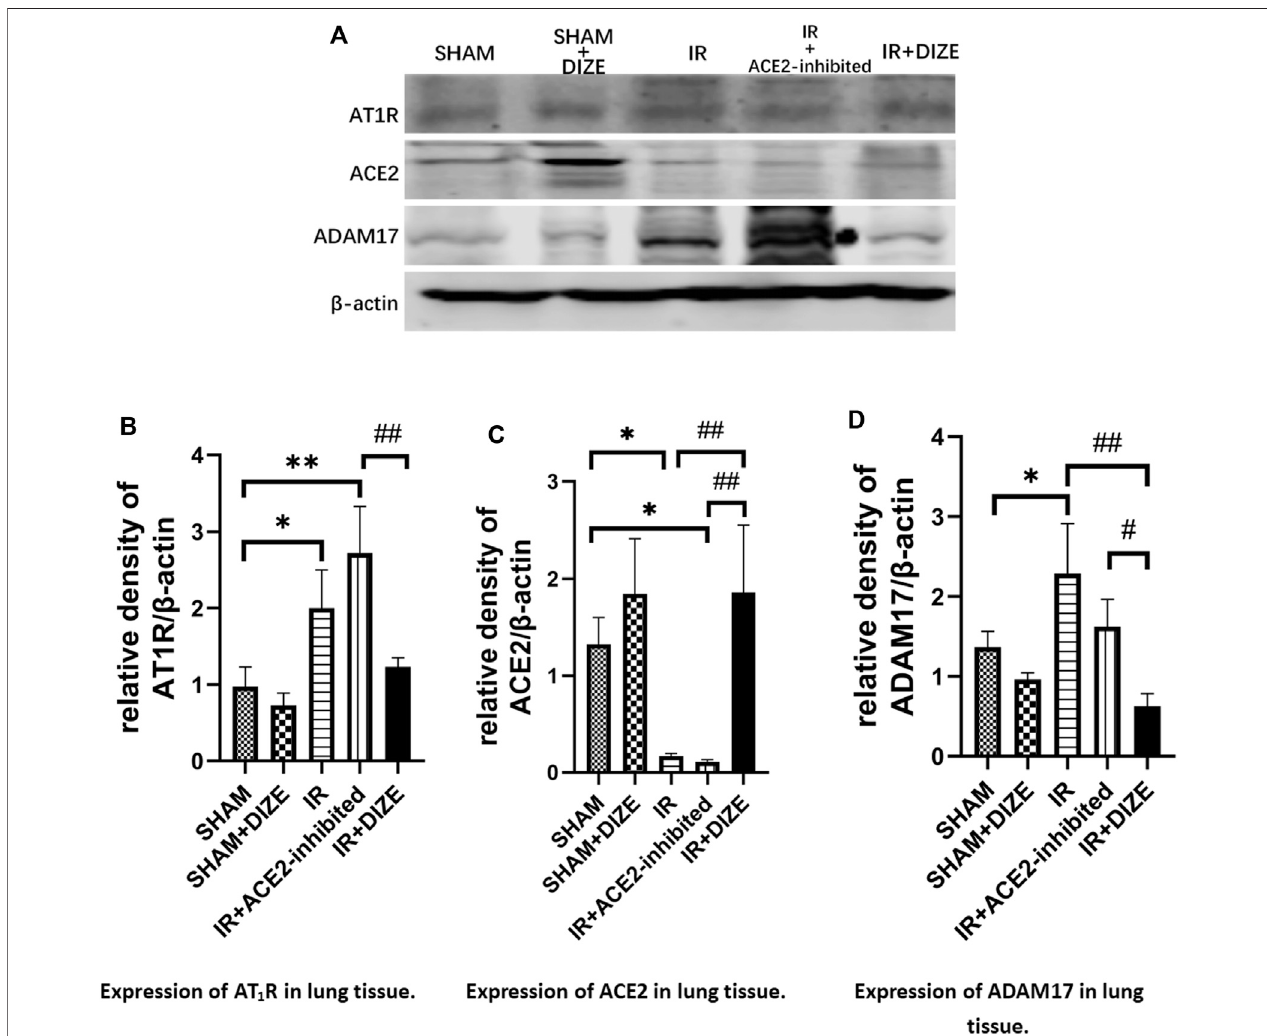
FIGURE6| DIZEreducedADAM17expressionafterIRinjuryandprotectedlocalACE2duringlungIRinjury. (A) WesternblotanalysisofAT 1 R,ACE2andADAM17 expression. (B) Relative quantitative expression of AT 1 R in rat lung (post-hoc analysis: Tukey ’ s test). (C) Relative quantitative expression of ACE2 in rat lung (post-hoc analysis: Tukey ’ s test). (D) Relative quantitative expression of ADAM17 in rat lung (post-hoc analysis: Tukey ’ s test). Data were expressed as mean ± SEM( n (cid:1) 7), *p < 0.05, **p < 0.01, ***p < 0.001 vs. SHAM group ; # p < 0.05, ## p < 0.01, # ## p < 0.001 vs. IR group .